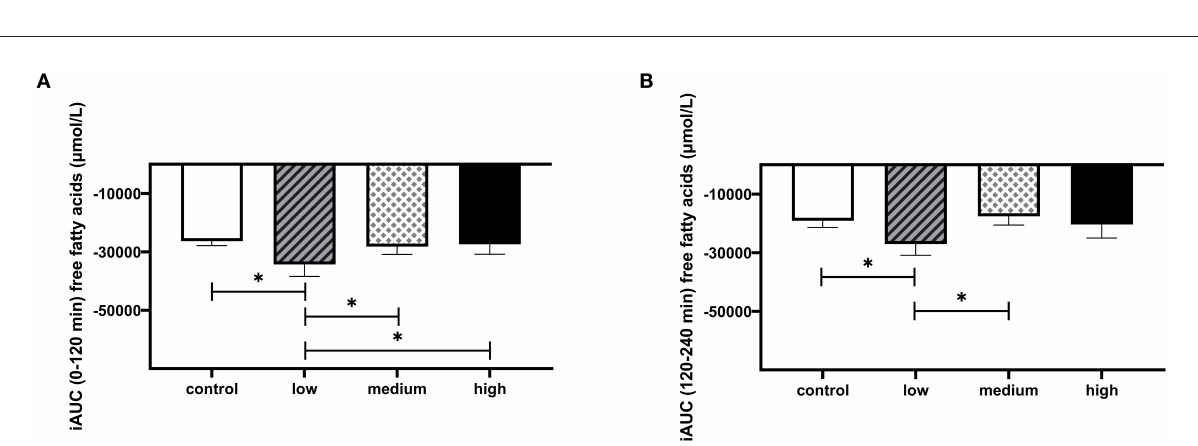
FIGURE6 The effect of butyrate and hexanoate-enriched triglycerides on circulating free fatty acids in first 4h after consumption. (A) iAUC for postprandial (t0–120min) plasma free fatty acids following butyrate and hexanoate-enriched triglyceride ingestion. Overall treatment effect (Type III Test of Fixed Effects) for postprandial (0–2h) plasma free fatty acids P = 0.086. (B) iAUC for postprandial (t120–240min) plasma free fatty acids following butyrate and hexanoate-enriched triglyceride ingestion. Overall treatment effect (Type III Test of Fixed Effects) for postprandial (2–4h) plasma free fatty acids P = 0.088. Values are presented as means ± SEMs ( n = 12). Differences in postprandial iAUC between the four doses interventions (control, low, medium, high) were analyzed by a linear mixed model for repeated measures and the indicated p-values represent post-hoc testing. Statistical significance indicated with an asterisk (*) if P < 0.05. iAUC, incremental area under the